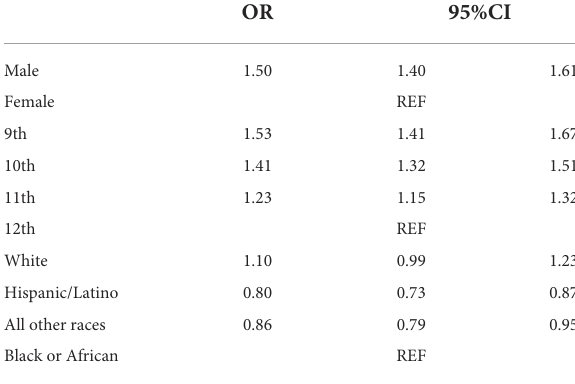
TABLE 2 Odds ratio and 95% CI for socioeconomic factors concerning sports participation in this study.